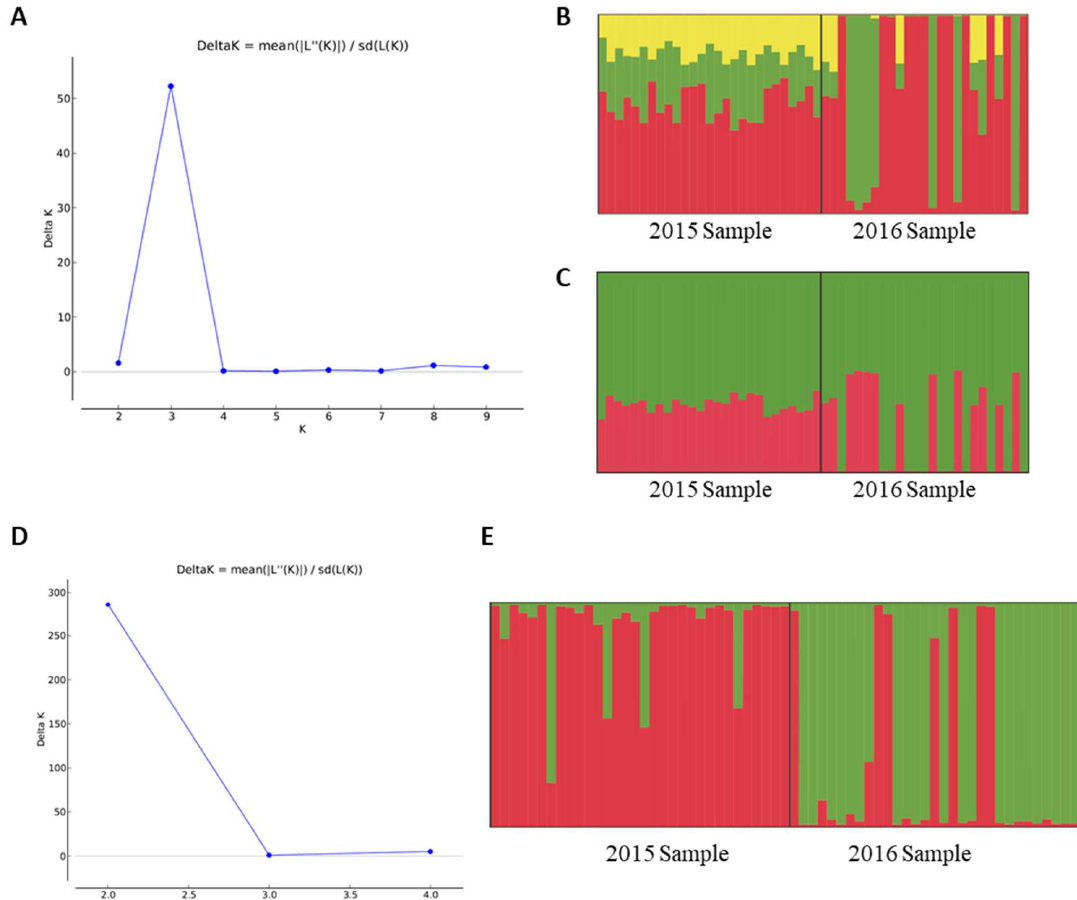
Figure 1. Structure results based on single-nucleotide polymorphisms (SNPs) and microsatellite data. ( A ) DeltaK from Evanno et al. method [47] indicating three clusters as the best K value for SNPs; ( B ) Structure inference based on SNPs, considering K = 3; ( C ) Structure inference based on SNPs, considering K = 2; ( D ) DeltaK from Evanno et al. method [47] indicating two clusters as the best K value for microsatellites; ( E ) Structure inference based on microsatellites considering K = 2. In ( B , C , E ), each color represents a genetic group and each vertical line represents an individual (for SNPs there is a total of 52 individuals, while for microsatellites there are 63). Each individual is colored proportionally to its probability of assignment to each genetic group.